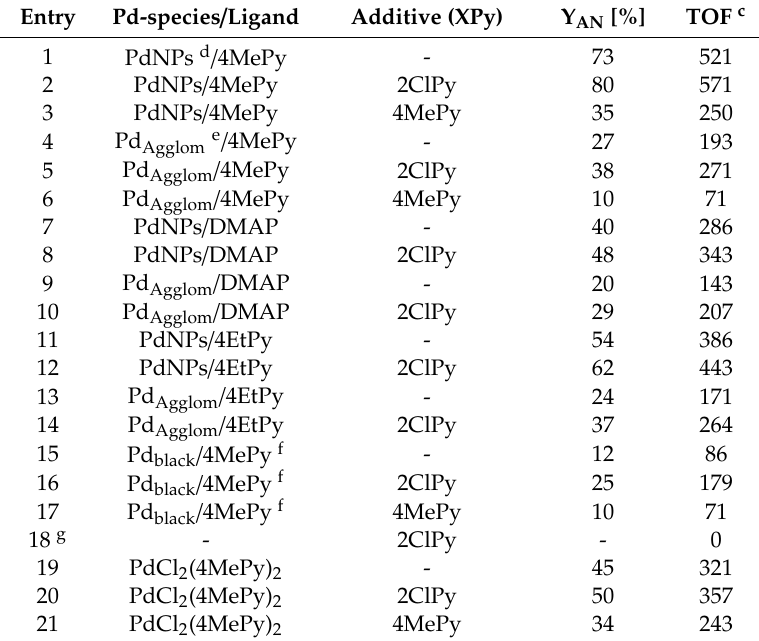
Table 1. The yield of aniline (Y AN ) obtained from the nitrobenzene reduction with CO / H 2 O in the presence of 0.056 mmol Pd-species and values of TOF.